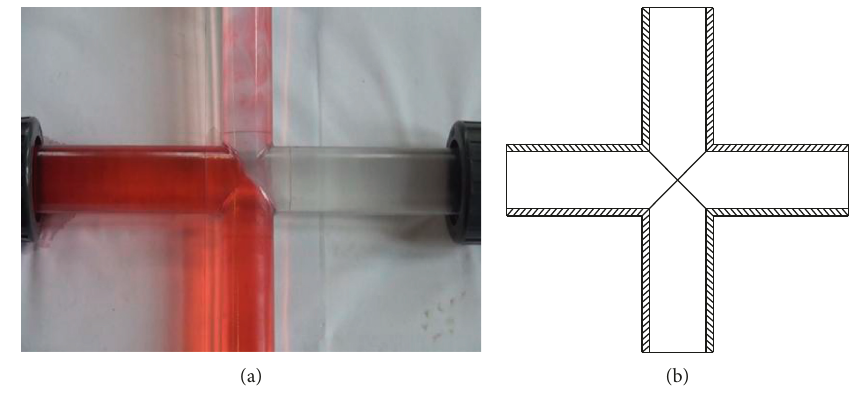
Figure 11: The geometry of joint used in this study.